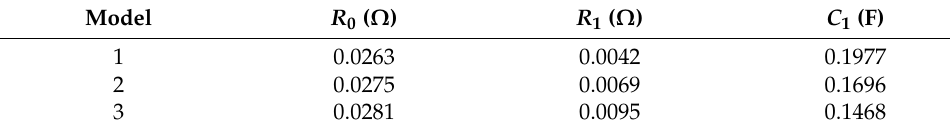
Figure 9. Electrochemical impedance spectrum curves of the battery at three cycle counts. Table 2. Values of resistance and capacitance parameters at different SOH.